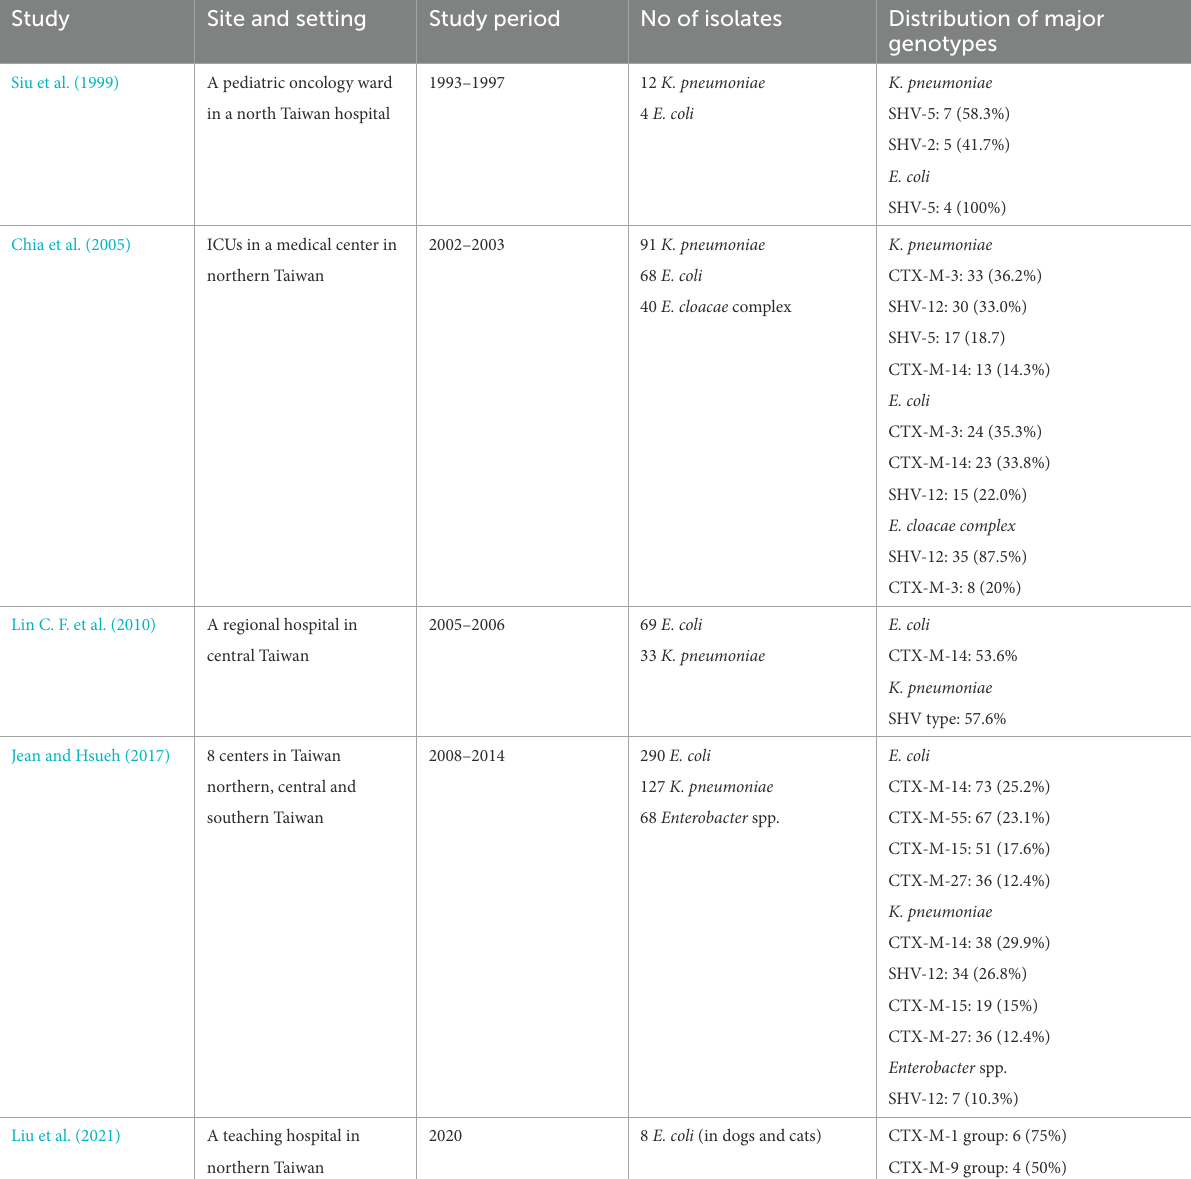
TABLE 2 Genotypic distribution of extended-spectrum β -lactamases (ESBLs) among Enterobacterales in Taiwan.